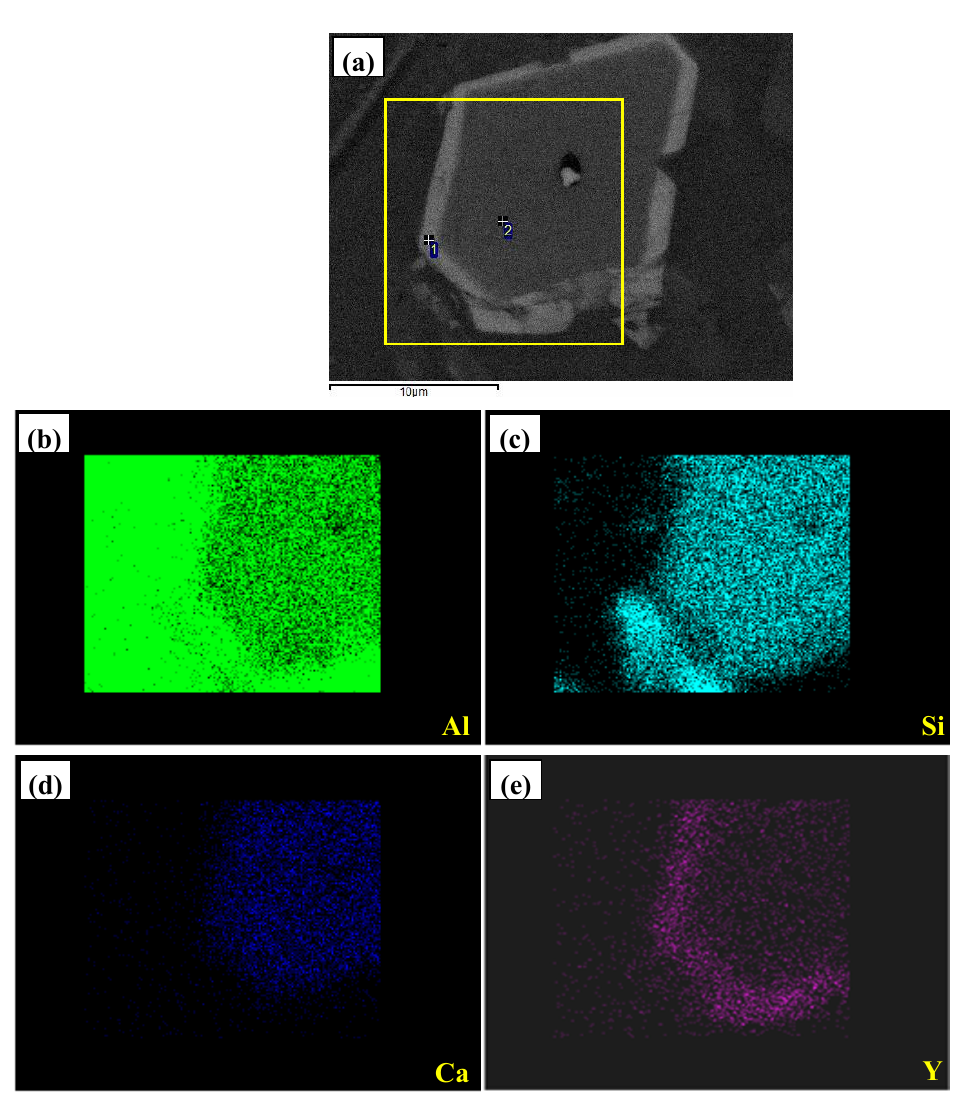
Figure 10. ( a ) microstructures; ( b – e ) the X-ray images for elements Al, Si, Ca, Y, respectively. Table 1. The corresponding chemical compositions of spots in Figure 10a. Spot Element